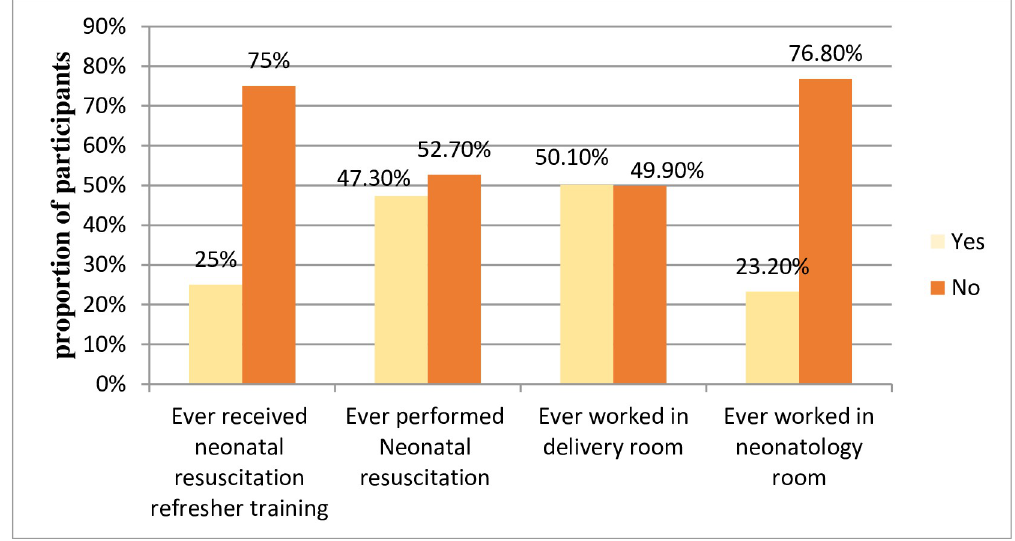
Fig 1. Refresher training and work-related exposure of midwives and nurses working in public health facilities in Eastern Ethiopia, November 2018 [n = 427].